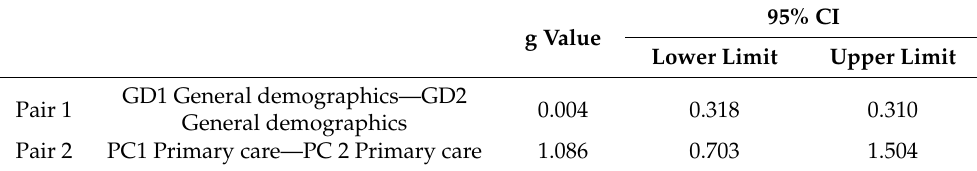
Table 4. Effect sizes for Hedge’s g dependent